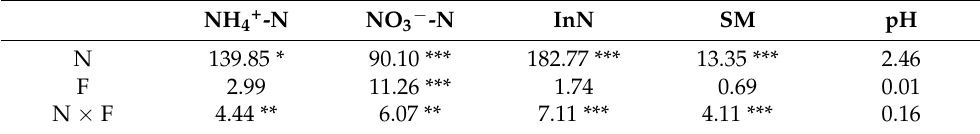
Table 2. Results (F values) of two-way ANOVA testing the effects of N addition levels (N) and frequencies (F) on NH 4+ -N, NO 3 − -N, InN, soil moisture content (SM) and soil pH values.